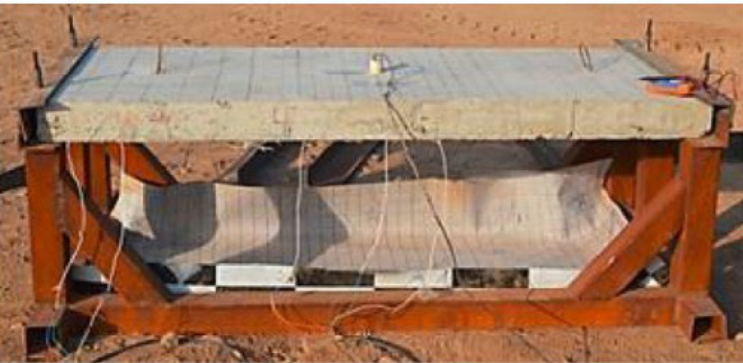
Figure 3 - Test setup of the slab specimens tested by Li et al.